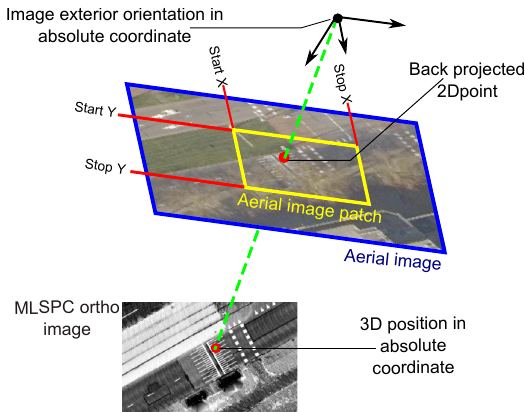
Figure 5. Acquisition of the aerial image patch by projection of 3D